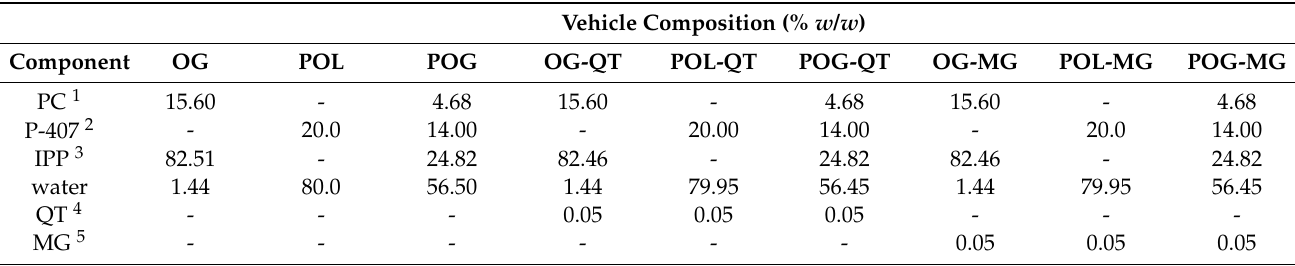
Table 1. Composition of semisolid vehicles employed for this